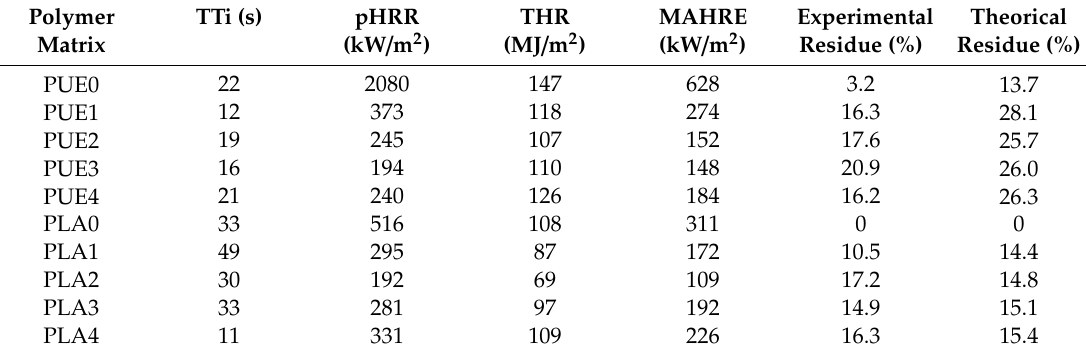
Figure 11. Heat release rate and mass for PLA/APP/S9 composites from cone calorimeter. Table 5. Cone calorimeter results for PUE/APP/S9 and PLA/APP/S9 composites.